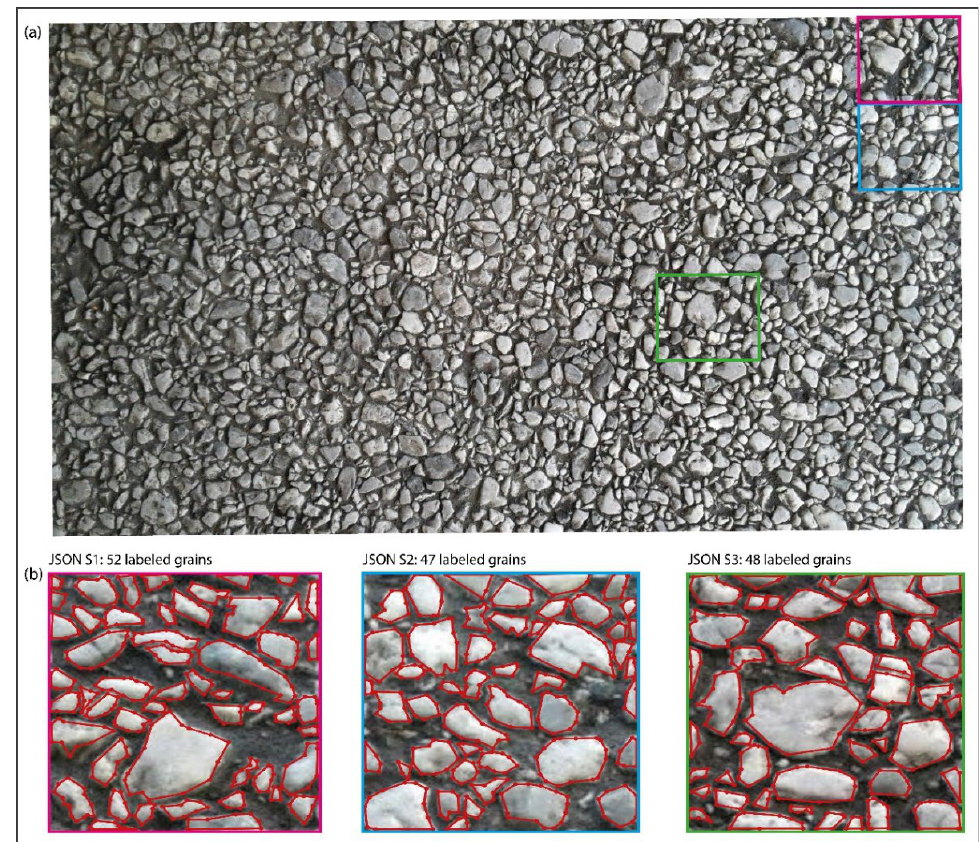
Figure 6. ( a ) The photograph of sandstone outcrop. ( b ) Three JSON files with 52, 47, and 48 labeled gravel grains. The JSON file with the pink edge, sky blue edge, and green edge corresponding to the place circled by the pink, sky blue, and green rectangles in ( a ).